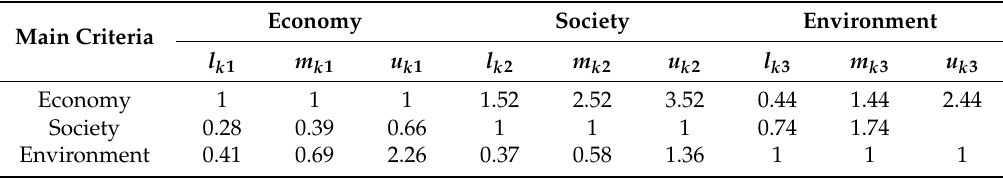
Table 3. Aggregated fuzzy pairwise comparison matrix for the main criteria.